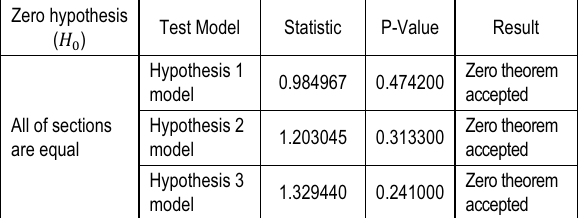
Table 4. Results of F-Limer test (similarity of